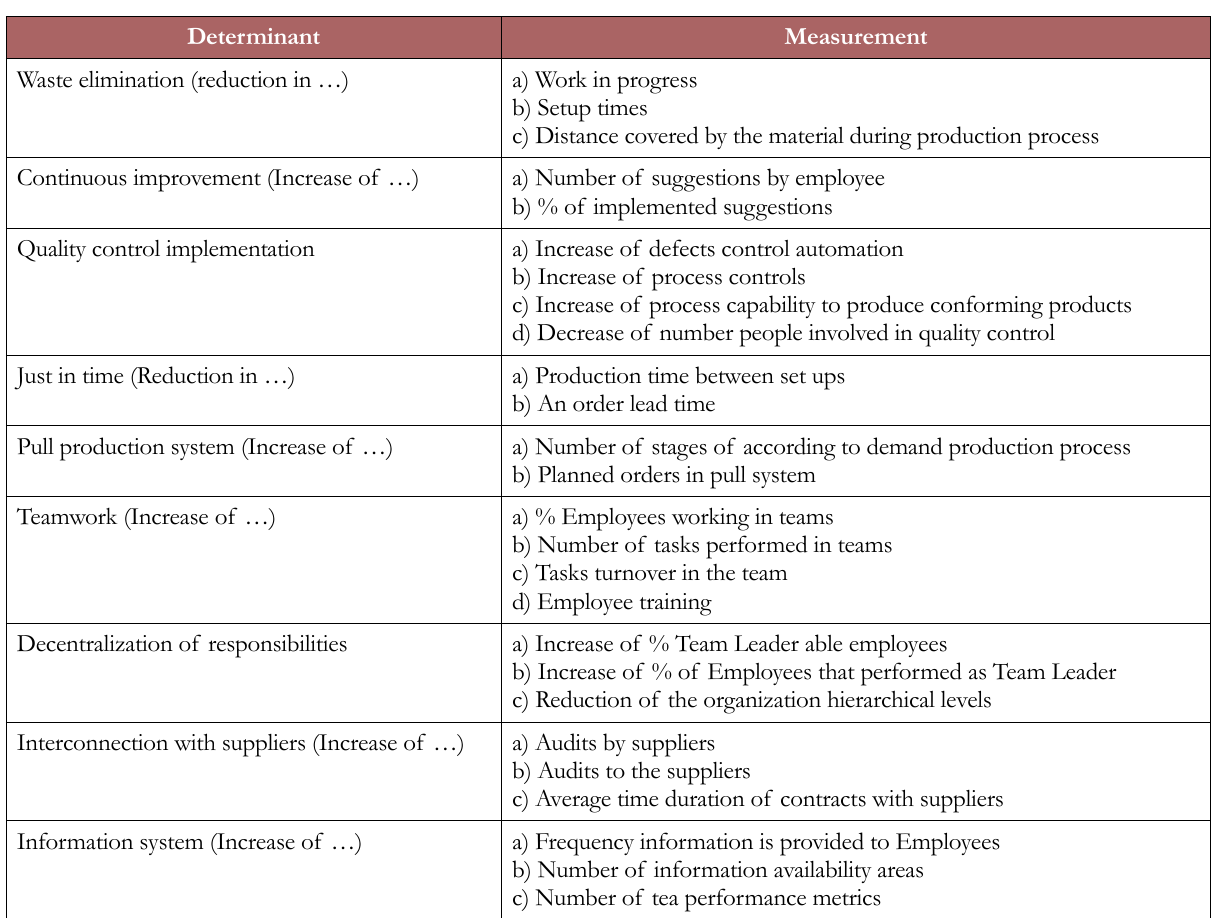
Table 1. Lean determinants (Karlsson & Åhlström,